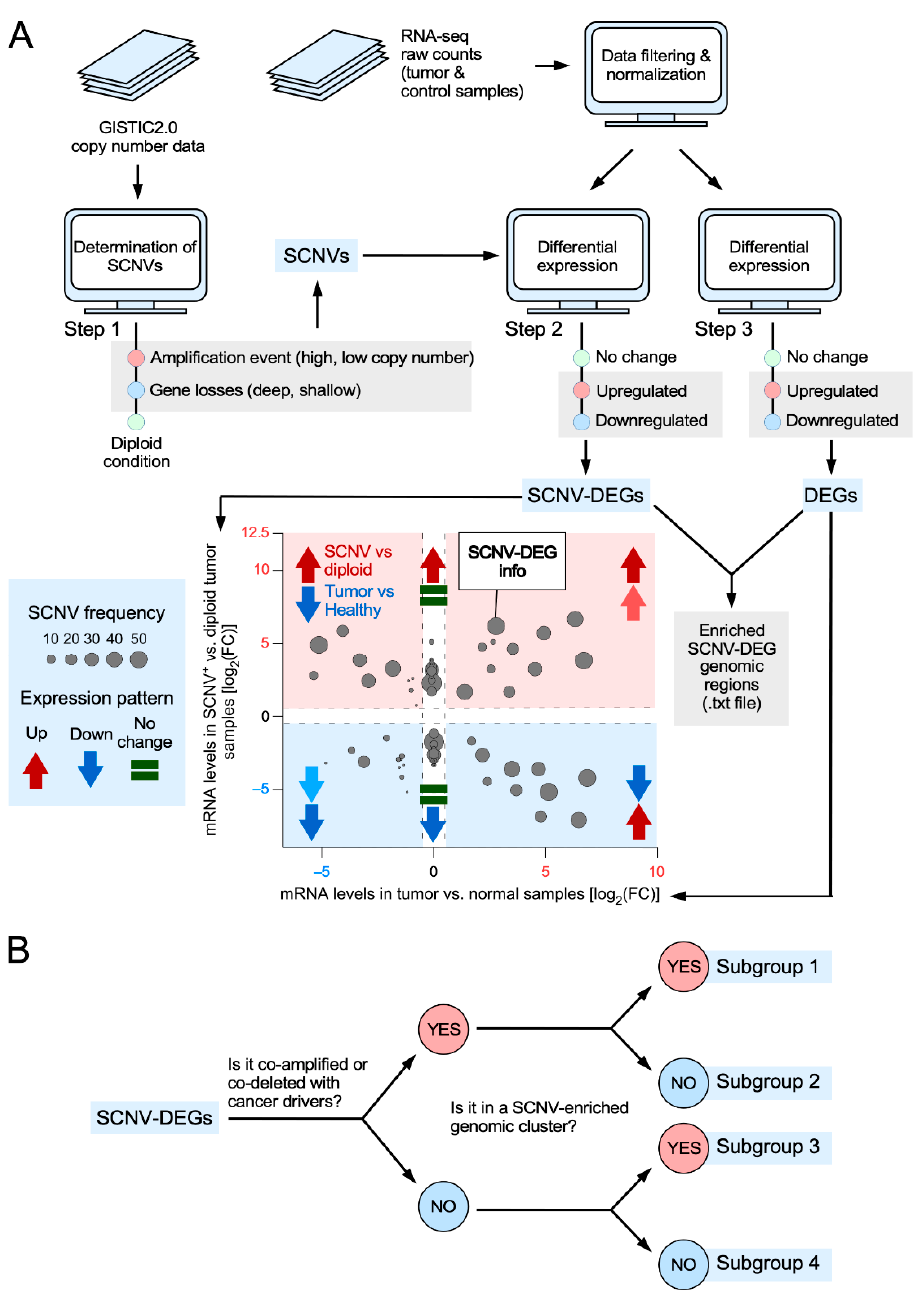
Figure 1. Scheme of the in silico pipeline used by the CiberAMP R package. ( A ) CiberAMP routine used to identify and visualize SCNV-DEGs. Icons used are explained in the blue box on the left. ( B ) Summary of the steps carried out by CiberAMP to classify SCNV-DEGs according to genomic con-